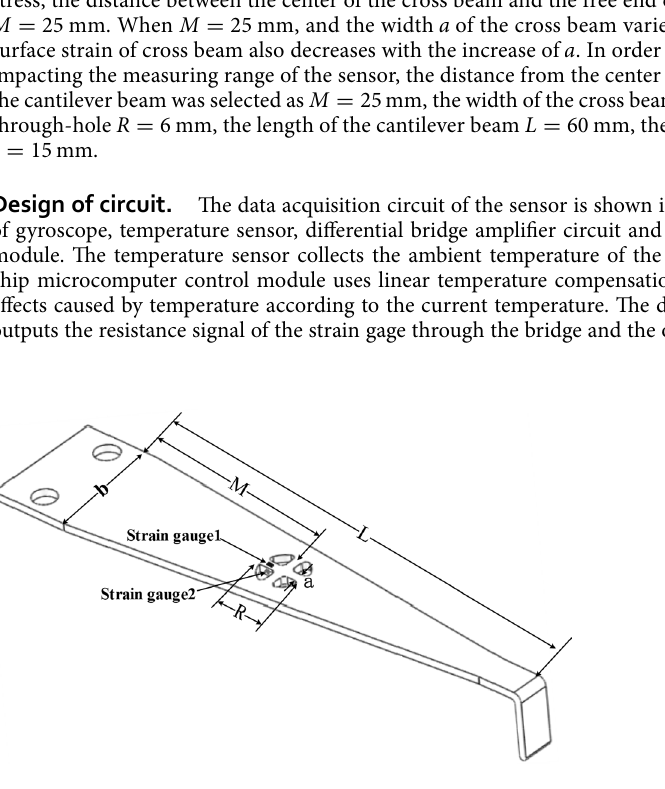
Figure 7. Structural schematic diagram of equal-strength cantilever beam with cross beam (The figure was generated by Microsoft Visio Professional 2016 (https:// www. micro soft. com/ zh- CN/ downl oad/ detai ls. aspx? id=